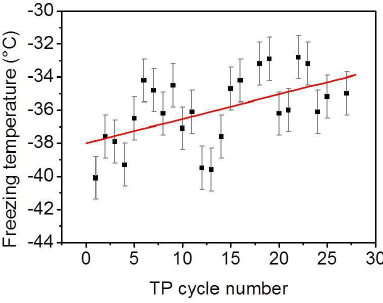
Figure 5. Freezing temperature of pH 3 solution as a function of the TP cycle number under the experimental conditions mentioned in the text. Black squares represent experimental data. Red line is a linear fit to follow the trend of the data points. The error bars have been evaluated from the standard deviation of different experiments.